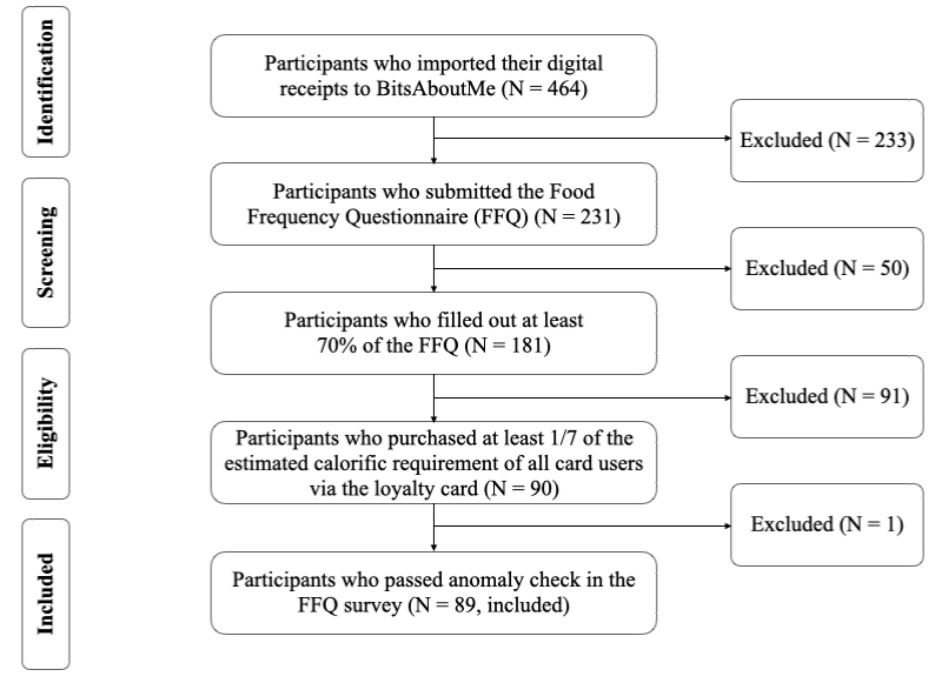
Figure 2. The procedure of excluding ineligible